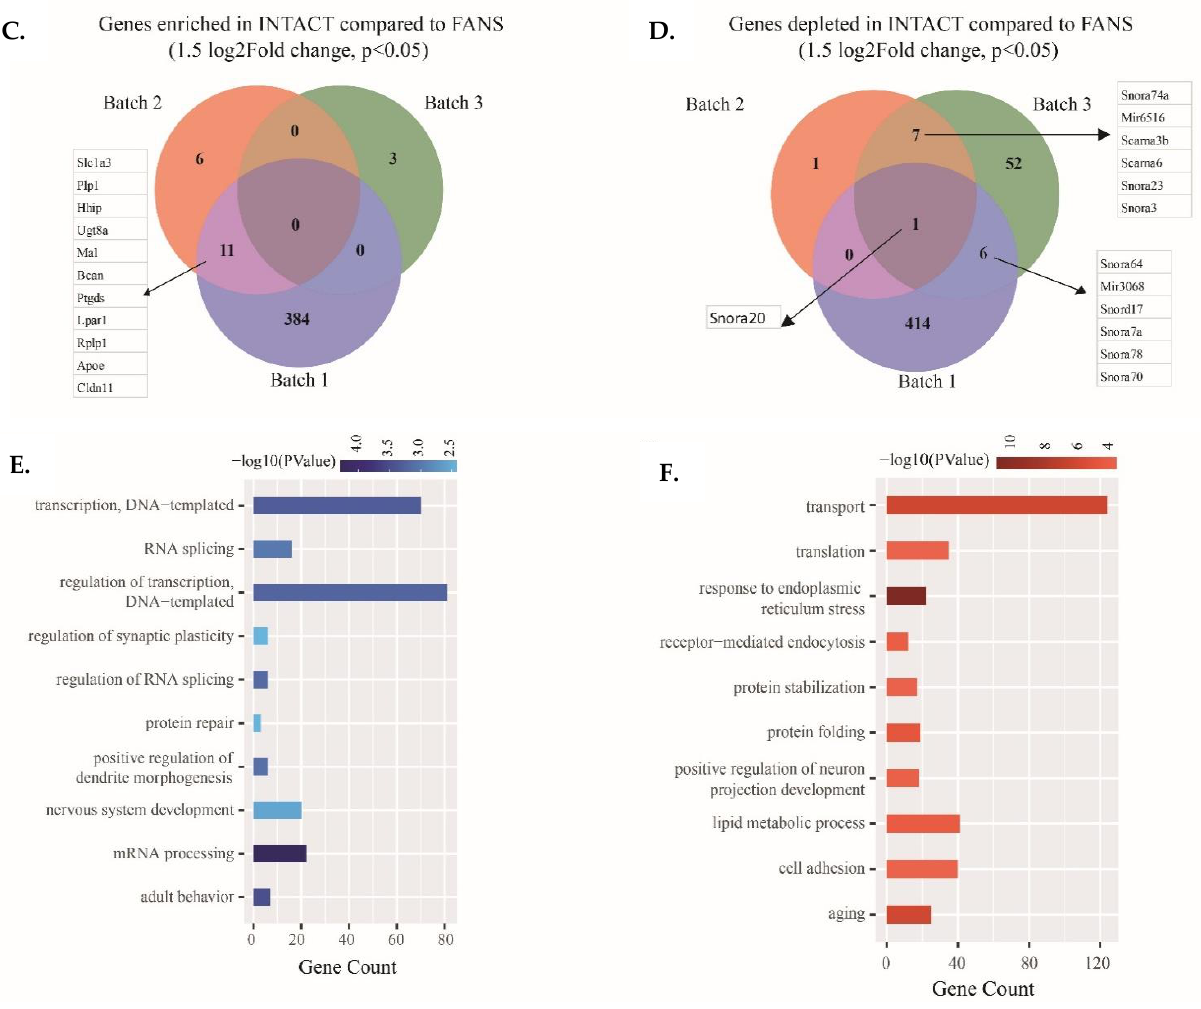
Figure 4. Transcriptional comparison between FANS- and INTACT-nuclei with distinct RIN values: ( A ) FANS/INTACT-mapped reads across the gene body based on library preparation strategy; ( B ) combined PCA from the three batches with distinct RIN values; ( C ) Venn diagrams of shared upregulated genes in INTACT compared to FANS among the 3 batches (1.5-fold change, p < 0.05); ( D ) Venn diagrams of shared downregulated genes in INTACT compared to FANS among the 3 batches (1.5-fold change, p < 0.05); ( E , F ) GO term enrichment analysis of INTACT-depleted ( E ) genes and enriched ( F ) compared to FANS. (Data represent depleted and enriched in INTACT compared to FANS).